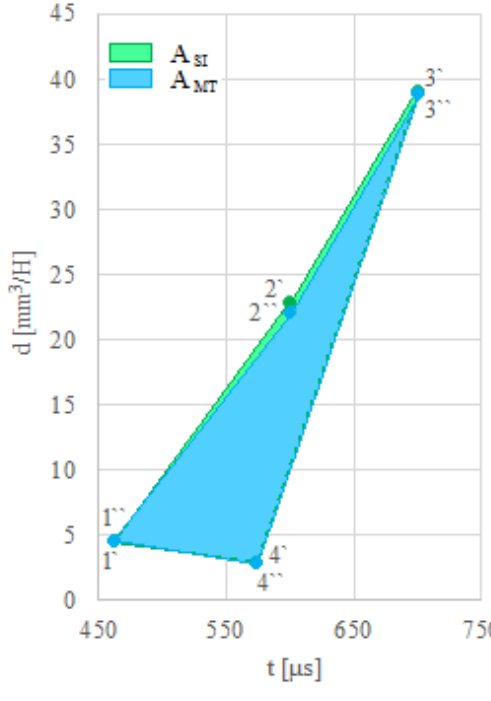
Fig. 6. Graphical interpretation of the main test